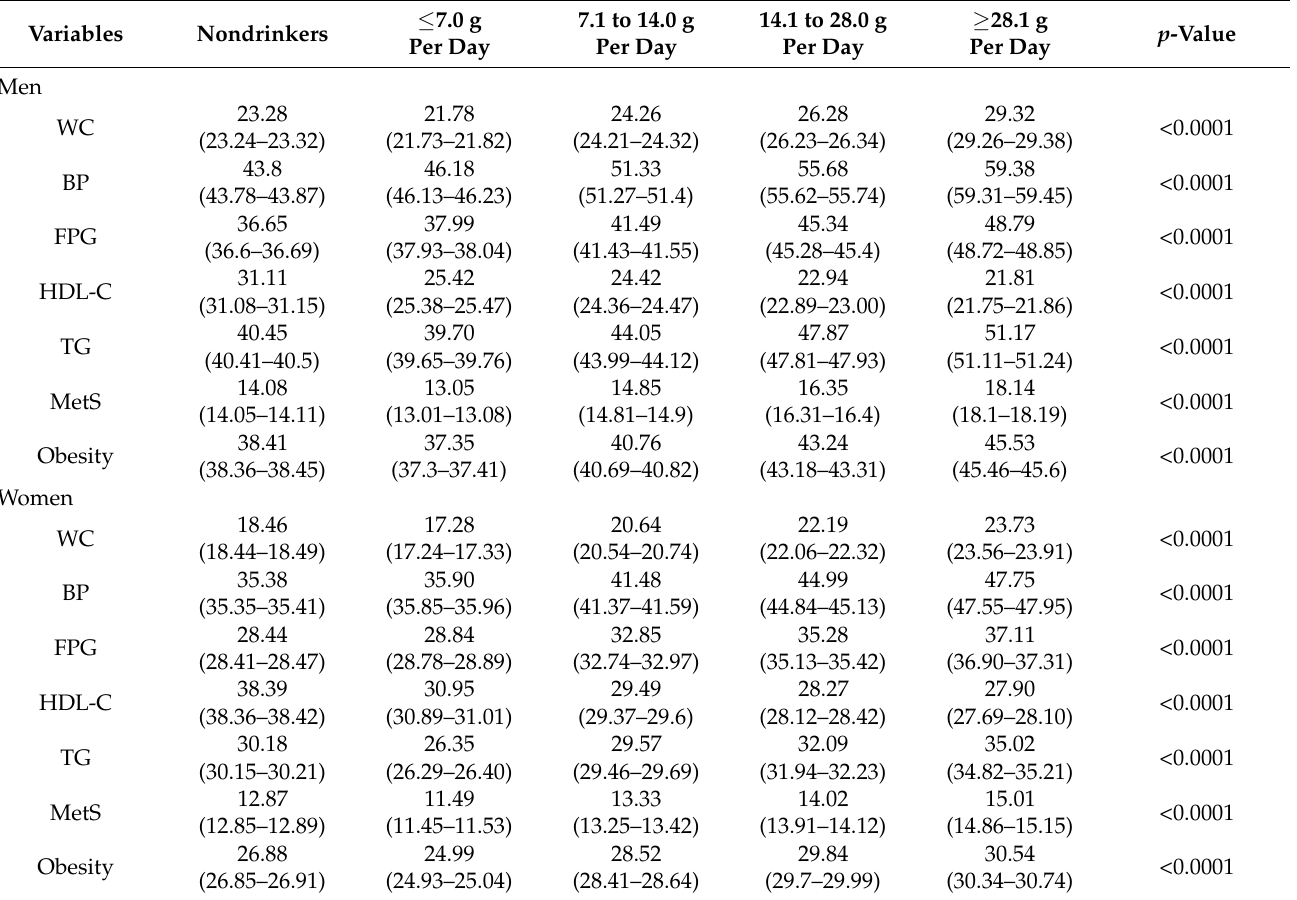
Table 2. Prevalence of the components of metabolic syndrome and obesity according to alcohol